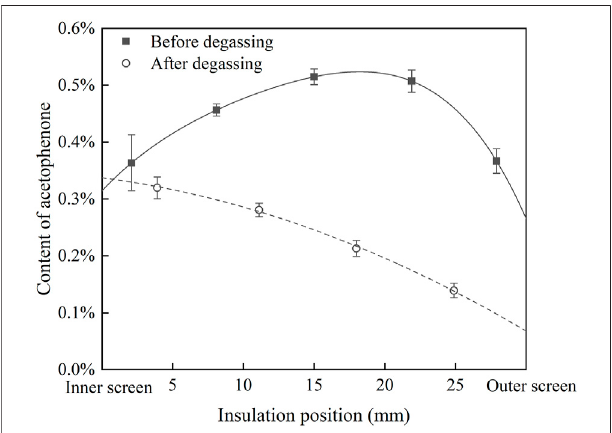
FIGURE 4 | Distribution of acetophenone in cable insulation before and after